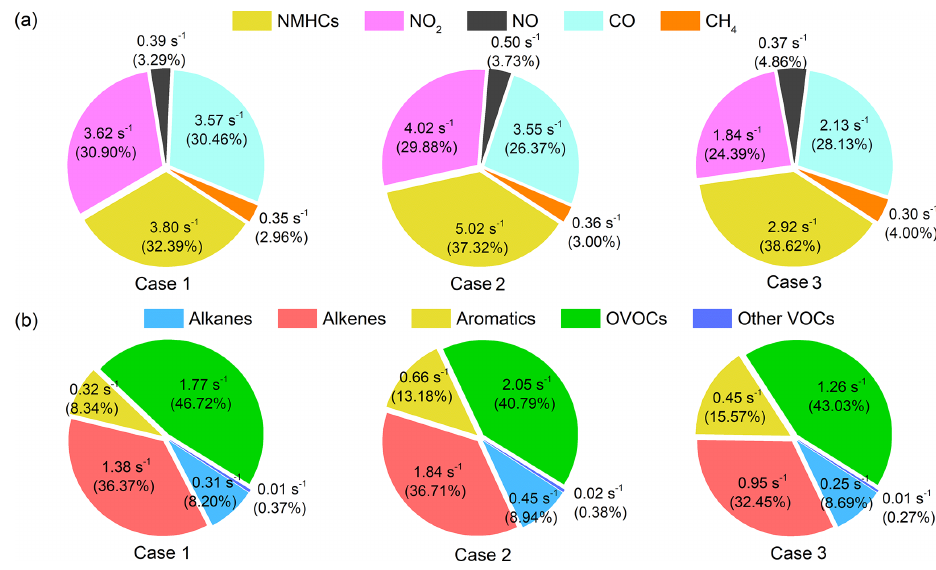
Figure 4. (a) The average contribution of major groups of reactants to the total OH reactivity during the three cases. (b) The contribution of each NMVOC group to the OH reactivity of NMVOCs during three cases.